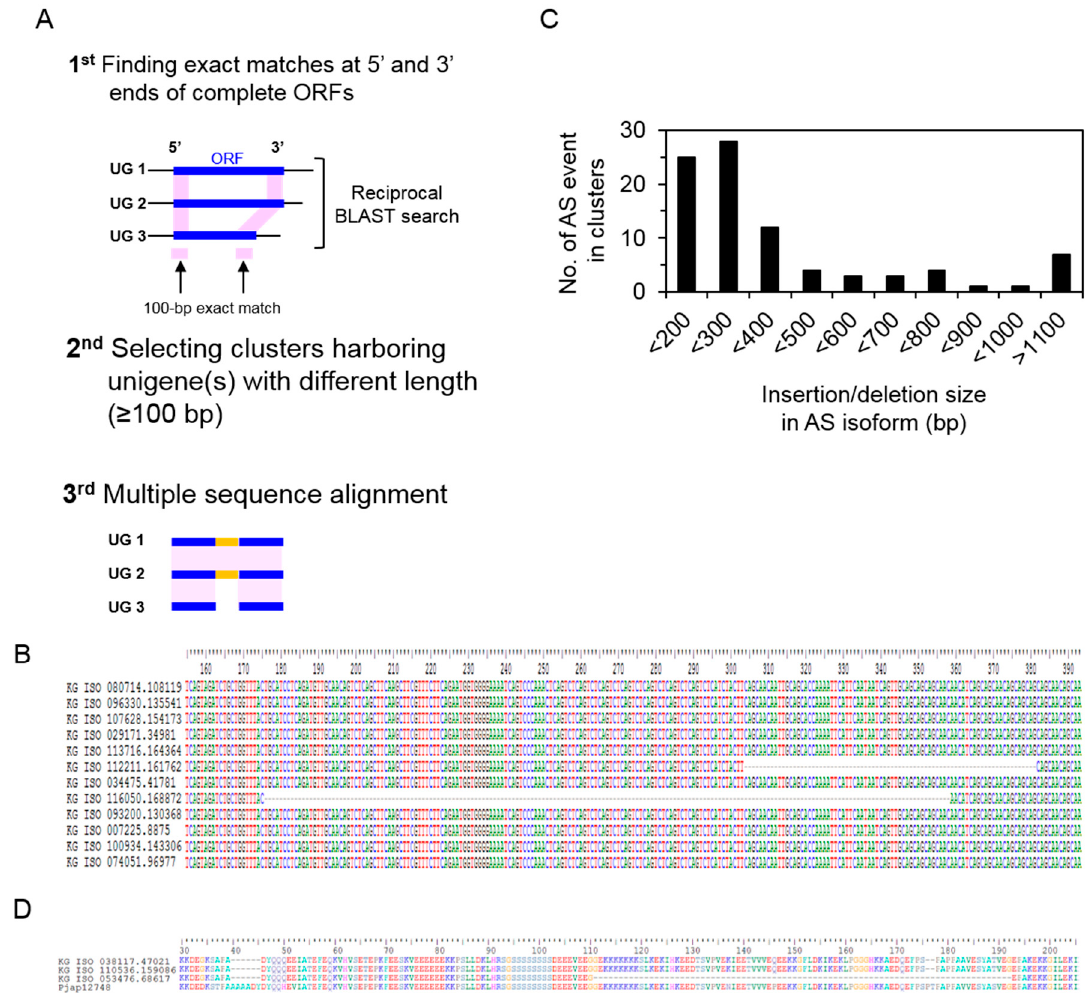
Figure 6. Identifications of alternative splicing isoforms within unigenes (UG) in P. ginseng . ( A ) Workflow for identifying alternative splicing (AS) events within unigenes. ( B ) Identifications of AS isoforms of ARF6 homologues. A total of 12 ARF6 homologous unigenes were clustered, and two regions showing of 78 (KG ISO 112211) and 183 (KG ISO 116050) base pair deletions were found. ( C ) The size of insertions/deletions (InDels) by AS events and the number of corresponding AS events in clusters. ( D ) Conservation of ERD14 between P. ginseng and P. notoginseng , and identifications of AS isoforms in P. ginseng .